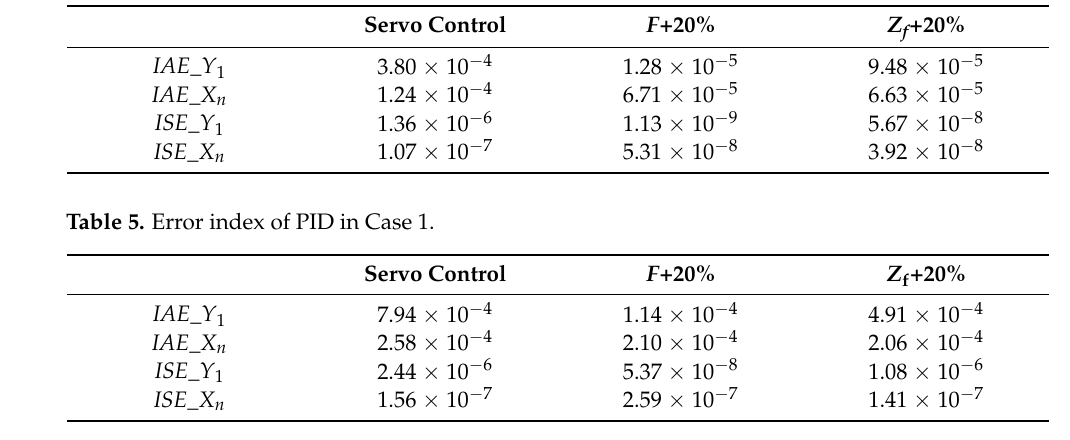
Table 4. Error index of GMC in Case 1.